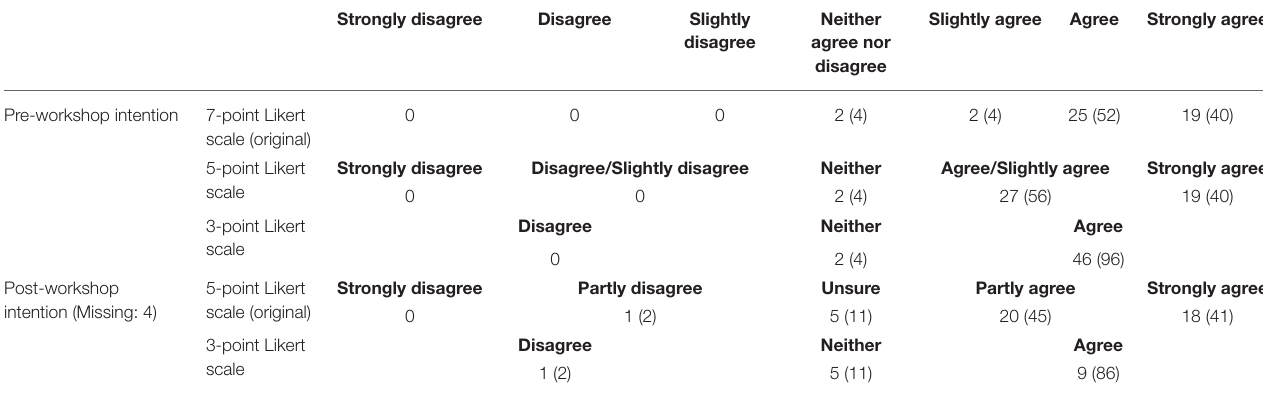
TABLE 3 | Pre- and post- “Train-The-Coach” SHRed Injuries workshop scores with Likert scale conversions [frequency (%)]. Strongly